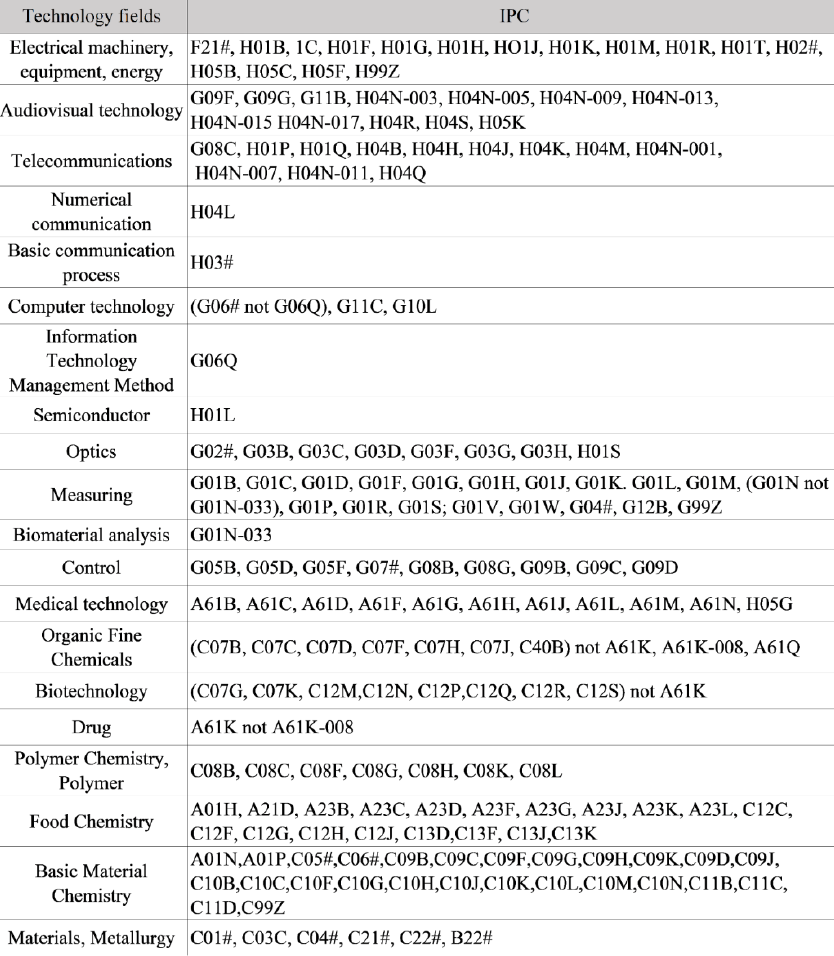
Fig. 3 IPC distribution in various